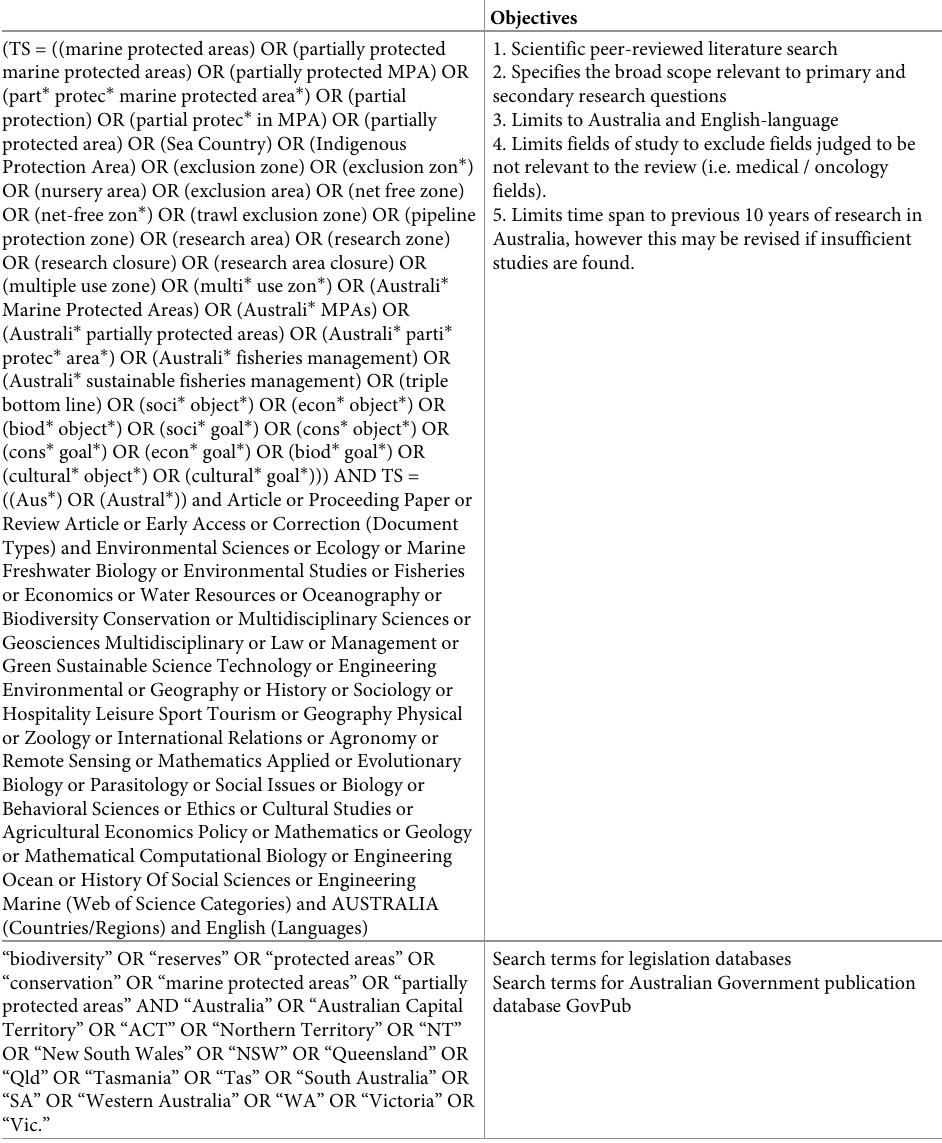
Table 3. The following BOOLEAN search terms will be used in the study, with their function displayed on the right. Included in the search is a filter to limit the scientific literature to the previous 11 years (2011–2022).